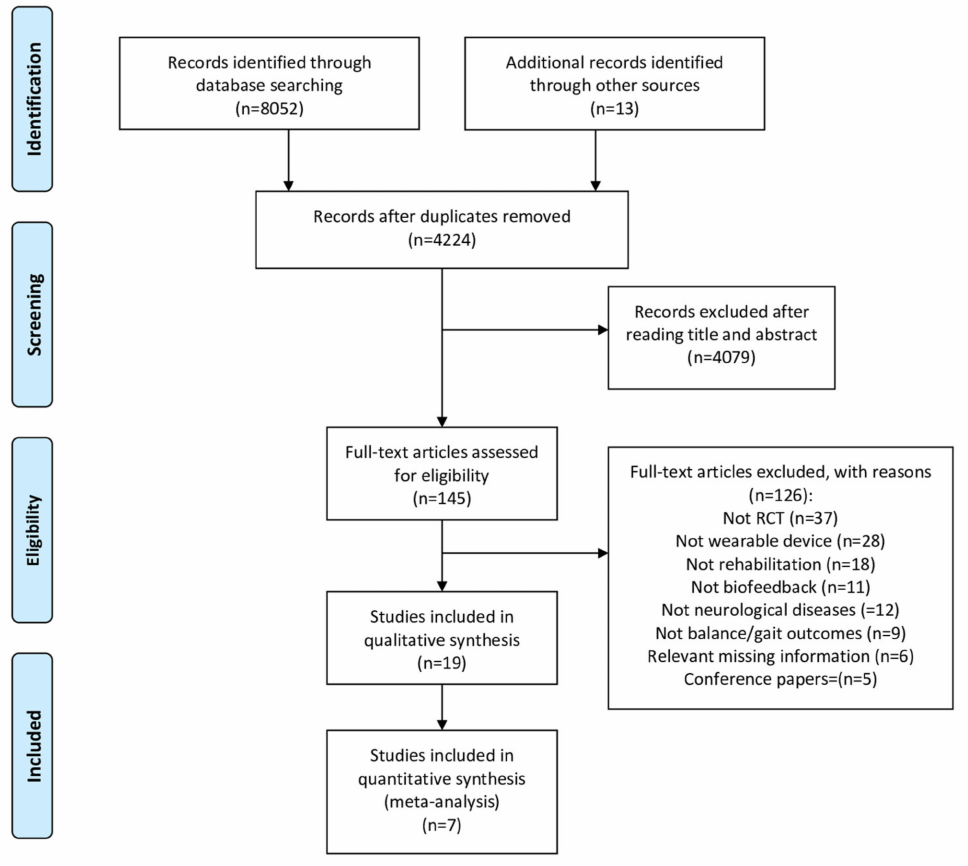
Figure 1. Flow diagram based on PRISMA statement (www.prisma-statement.org, accessed